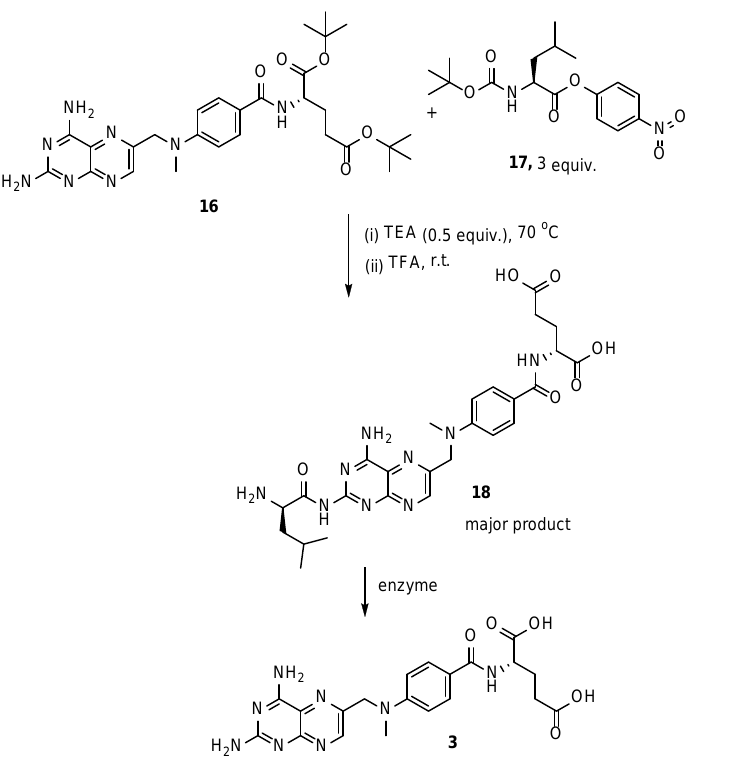
Scheme 8. Three-step synthesis of MTX starting from di- tert -butyl ester of MTX 16 and N - tert -butyloxycarbonyl- L -leucine derivative 17 .